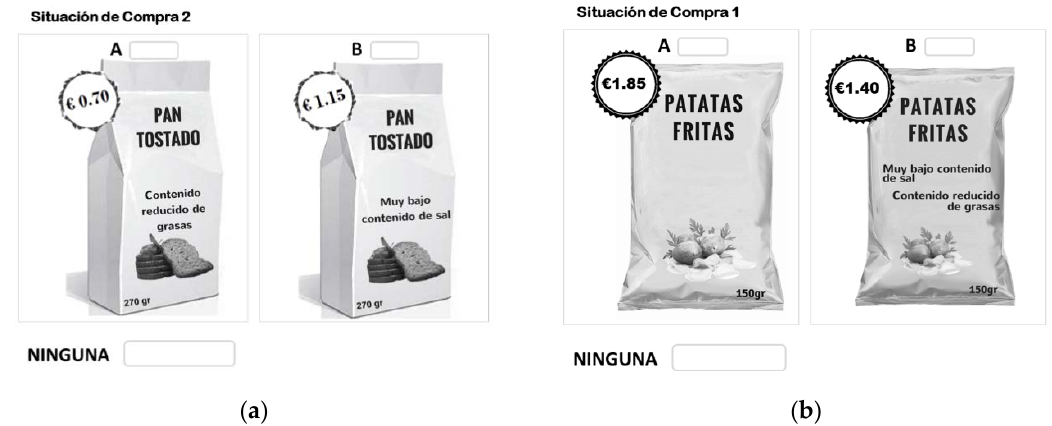
Figure 1. ( a ) Example of a choice set of toasted bread, and ( b ) example of a choice set of potato chips.